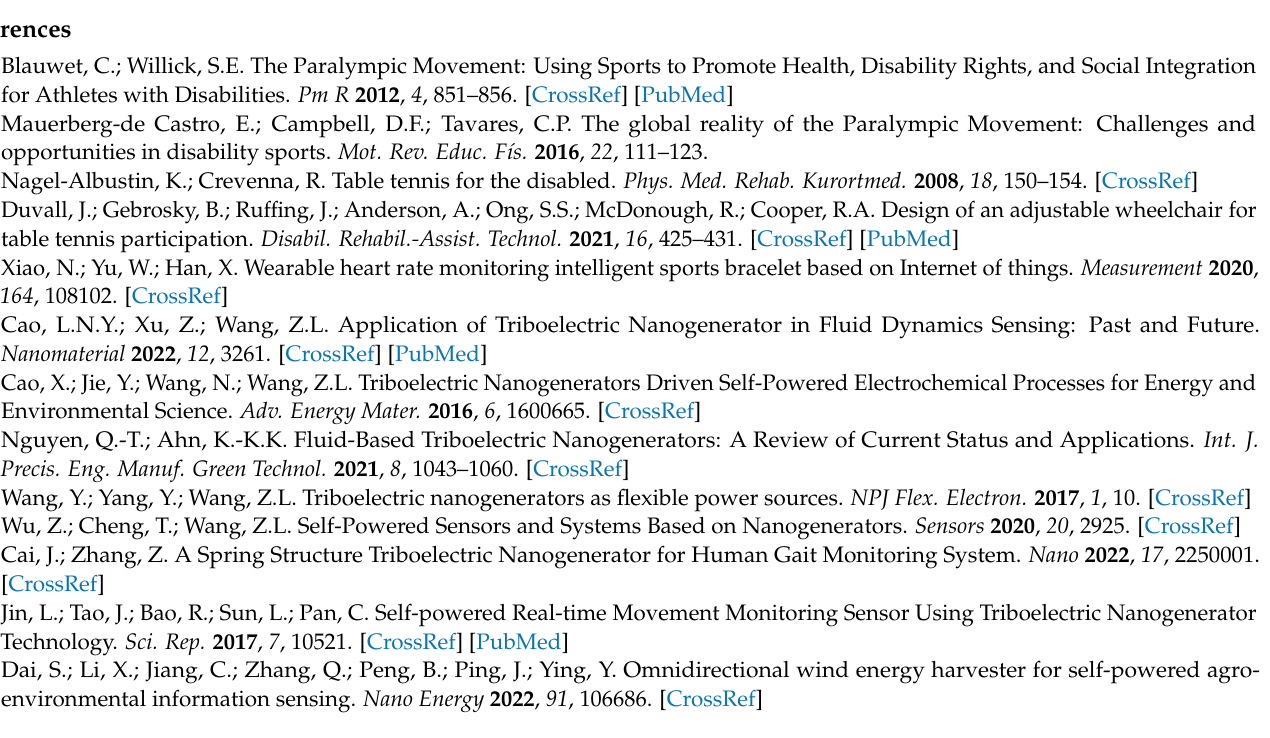
wheelchair; Figure S2: Working diagram of the PL-TENG simulated by a stepper motor; Figure S3: Information about the rectifier diode and the capacitor used; Figure S4: The PL-TENG